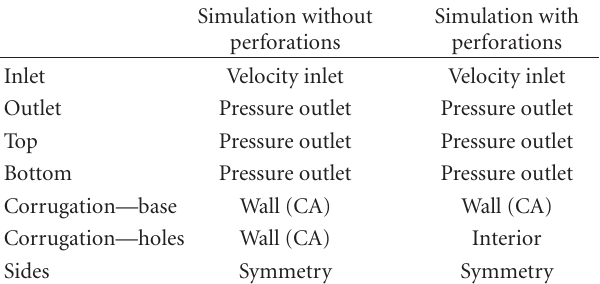
Table 2: Boundary conditions used in the simulations.